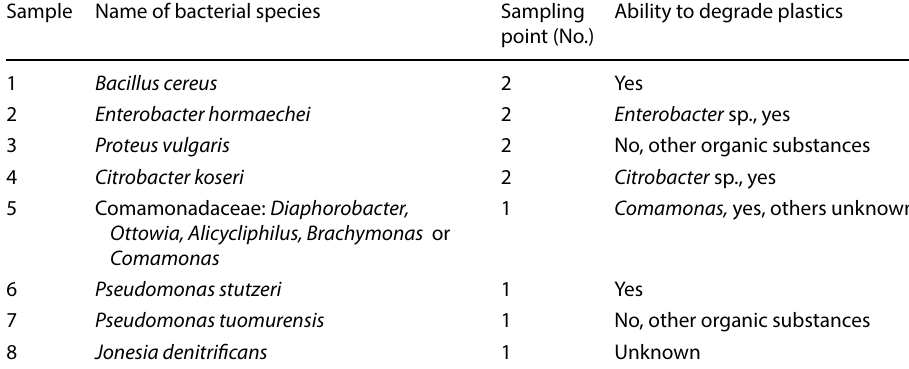
Table 2 Selected bacterial species